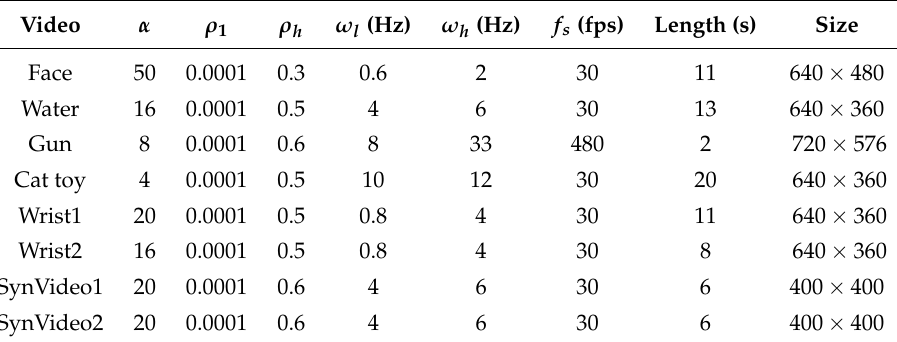
Table 1. Parameters for representative